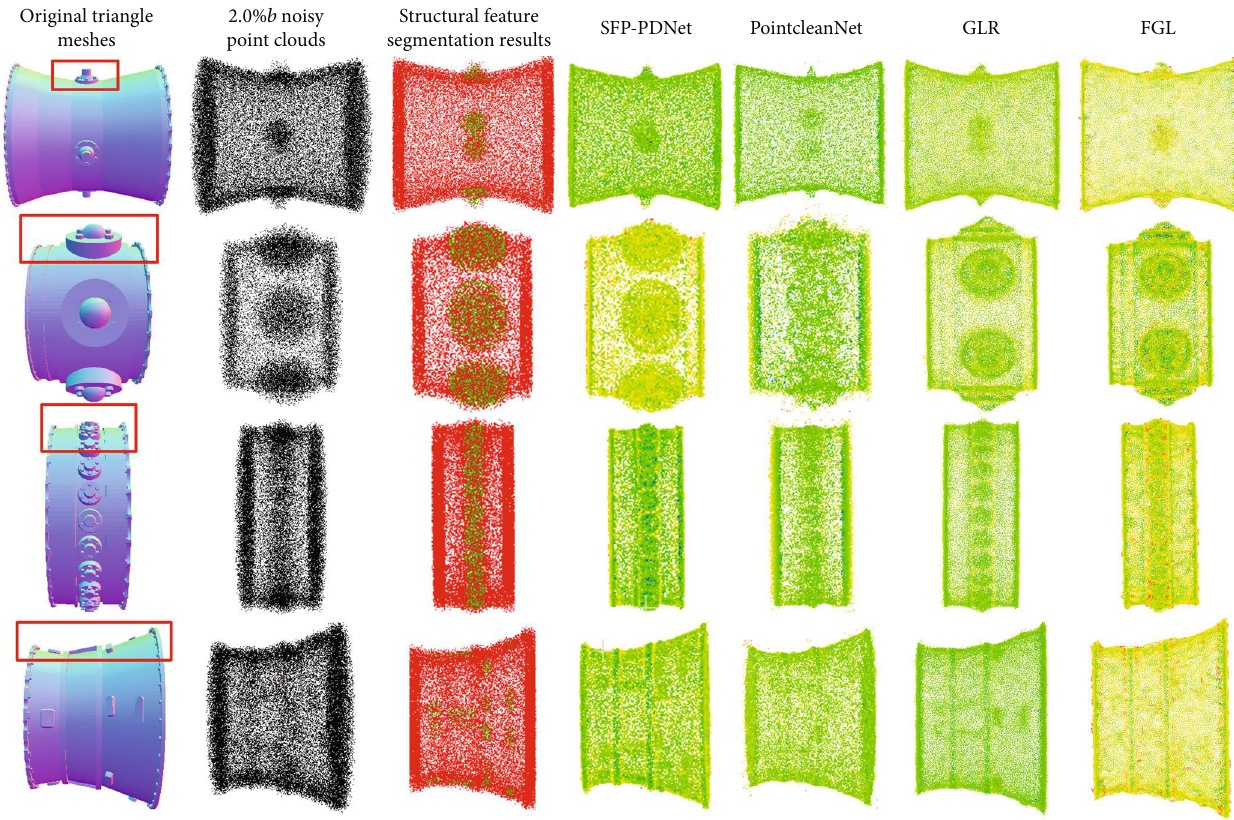
Figure 24: Comparison results of casings. From up to down are casing 1, 2, 3,